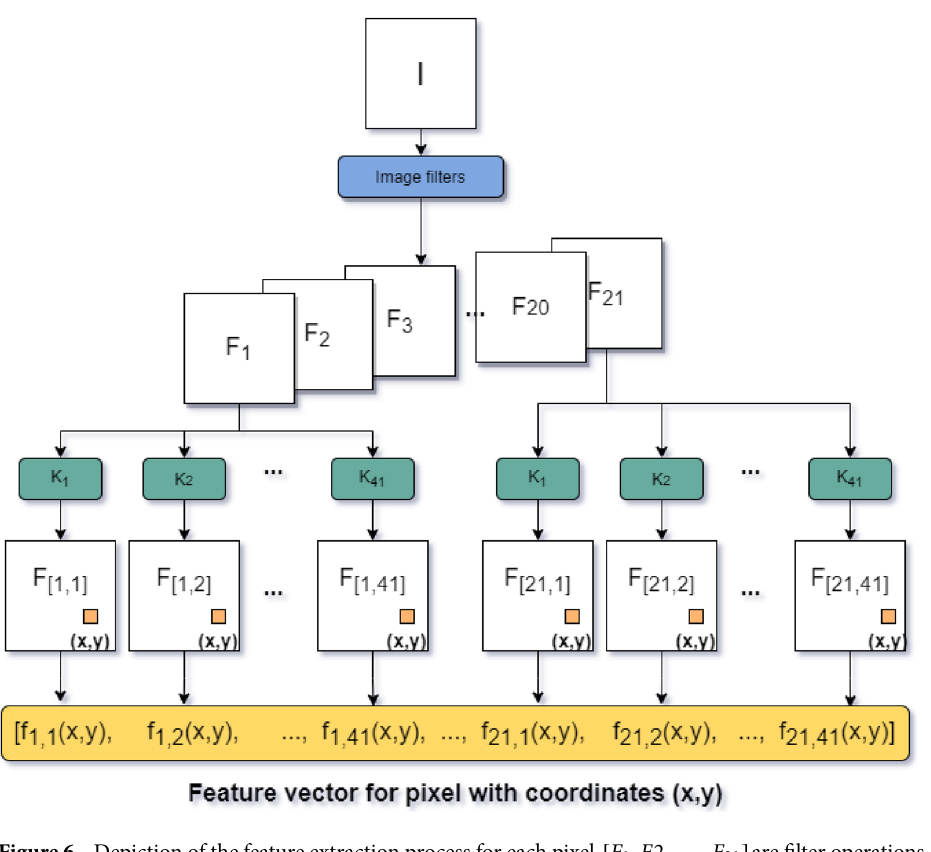
Figure 6. Depiction of the feature extraction process for each pixel. [ F 1 , F 2, . . . , F 21 ] are filter operations, the symbol ∗ denotes convolution, and [ k 1 , k 2 , . . . , k 4 1 ] correspond to texture extraction kernels.